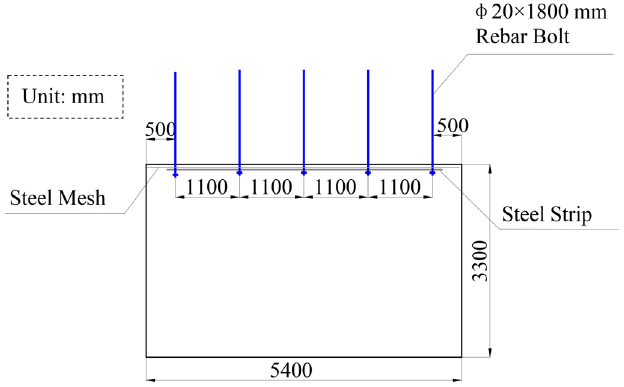
Figure 3. Previous support design.